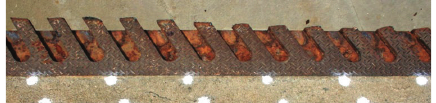
Figure 1: Finger joints used in this study.